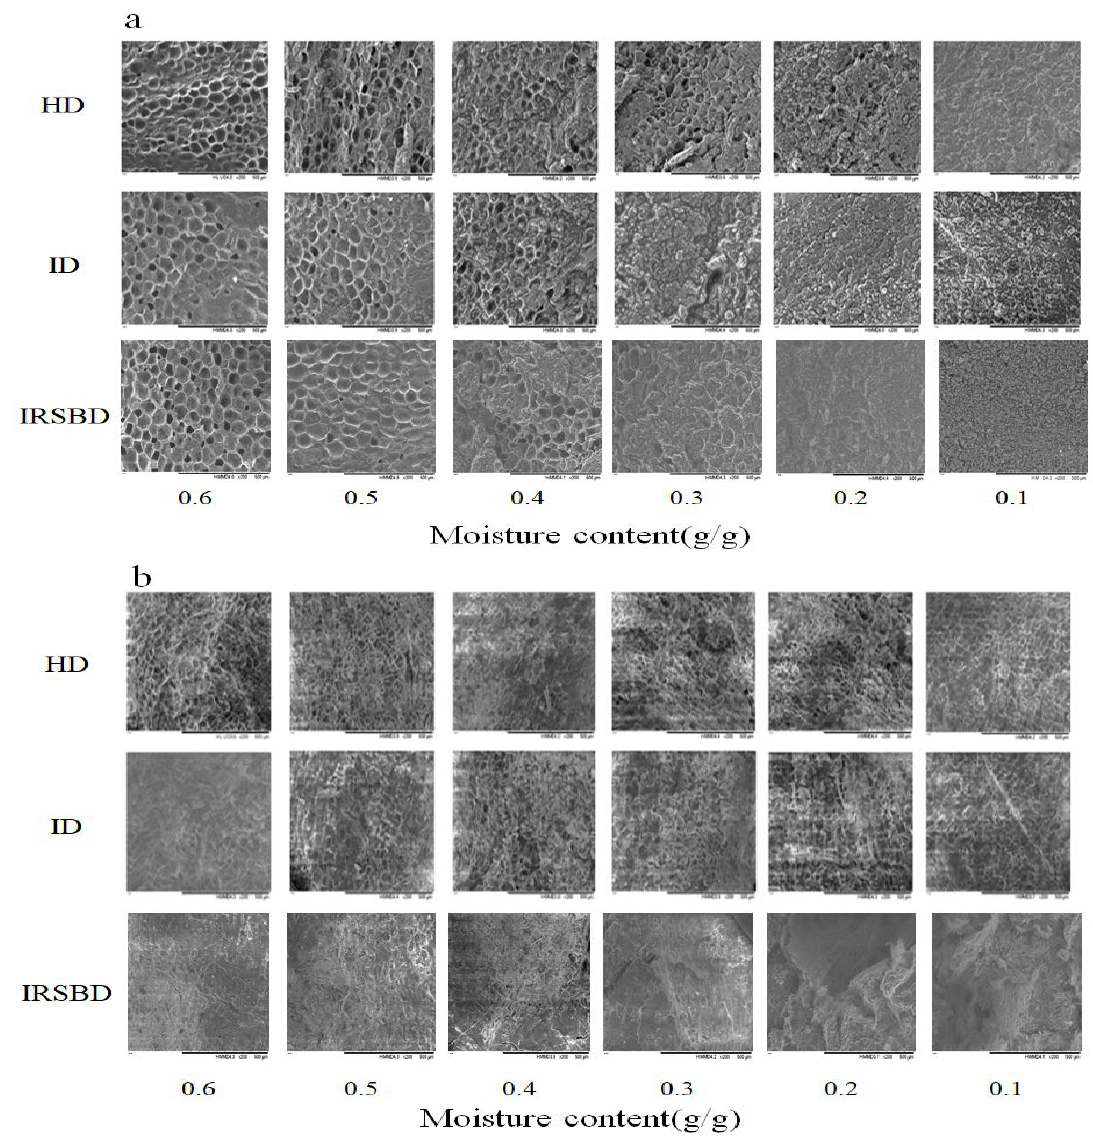
Figure 4. Microstructure observation of peanut kernels ( a ) and peanut shells ( b ) under different drying methods ( ×